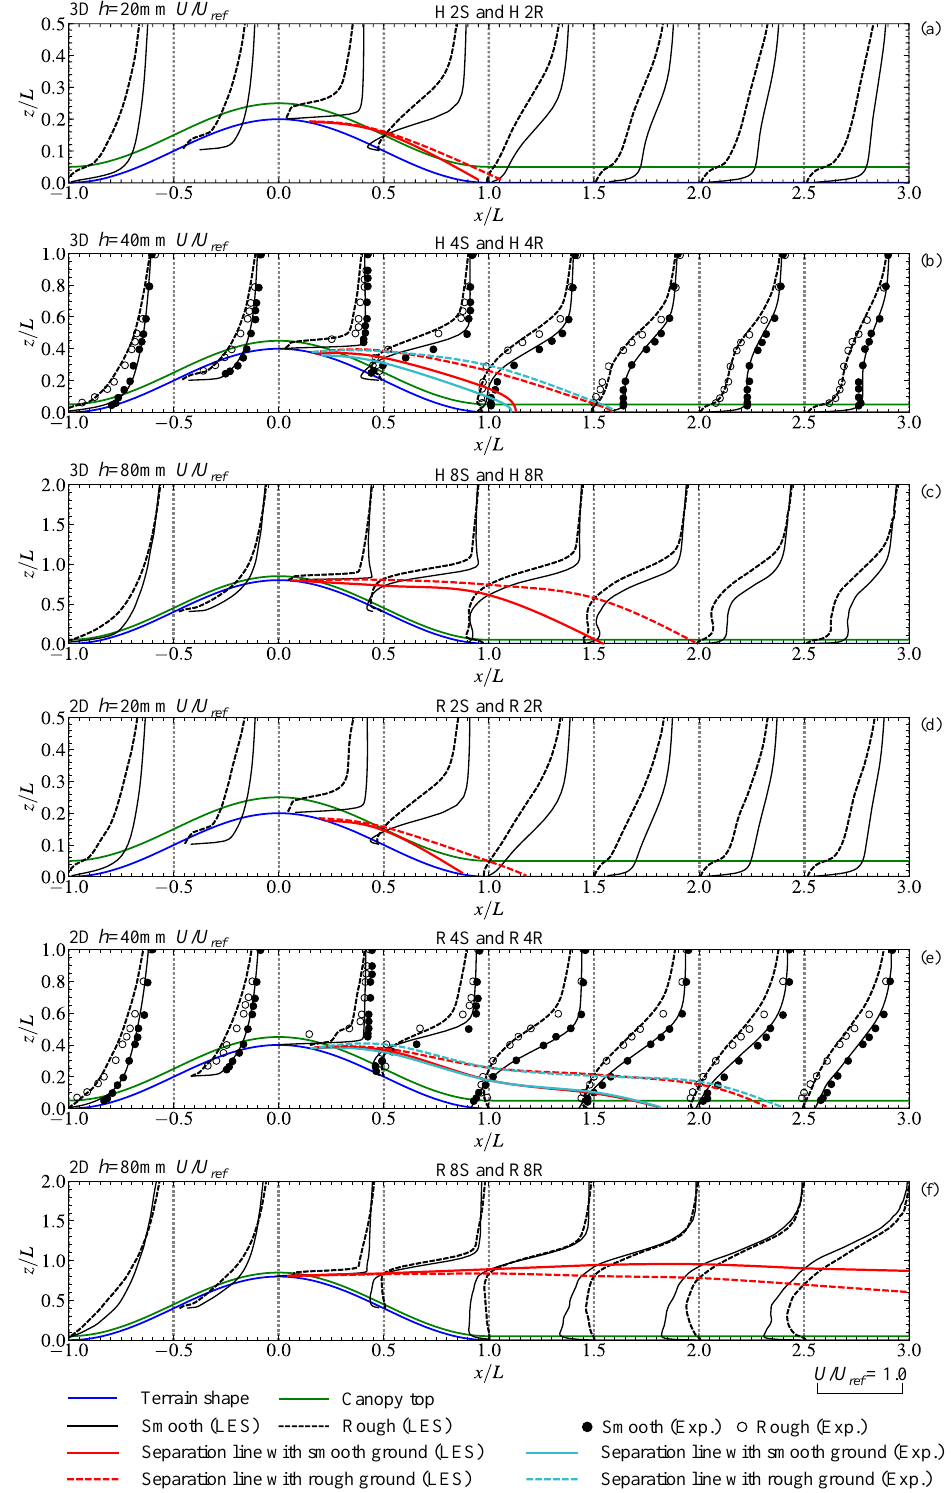
Figure 4. Vertical profiles of U , ( a ) 3D hills with h = 20 mm, ( b ) 3D hills with h = 40 mm, ( c ) 3D hills with h = 80 mm, ( d ) 2D hills with h = 20 mm, ( e ) 2D hills with h = 40 mm, and ( f ) 2D hills with h = 80 mm.